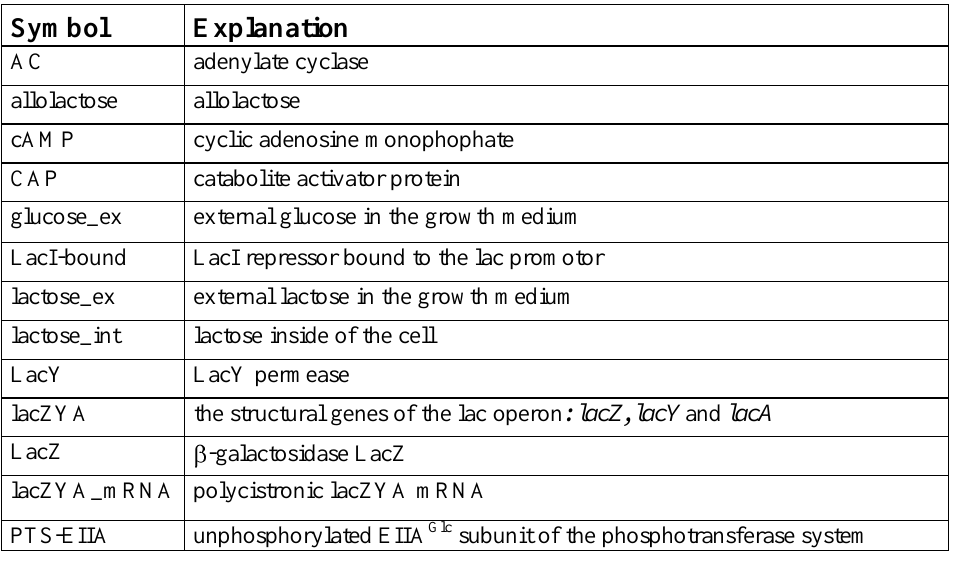
Table 1: Species of the Boolean lac operon model.